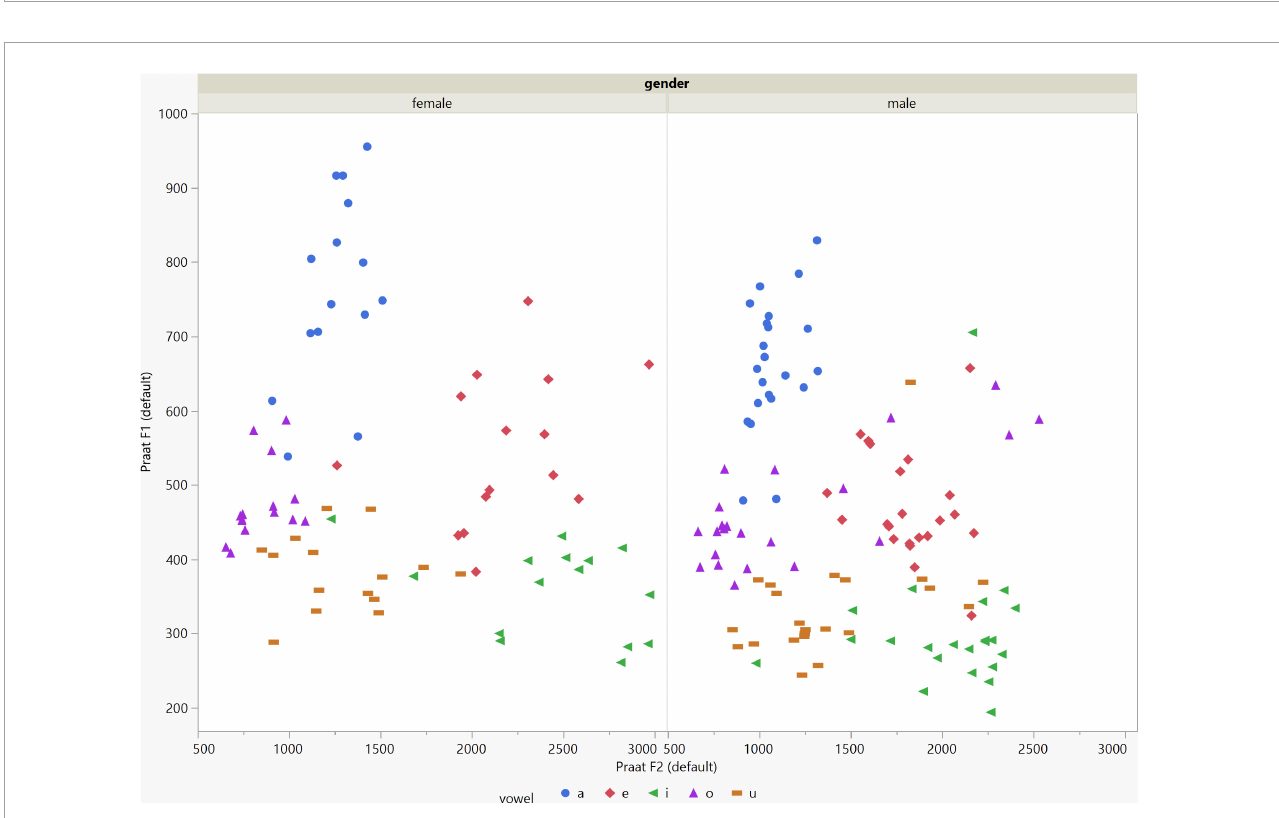
FIGURE3 Arrangement of the F1 and F2 data of the five vowels calculated using Praat with the default settings for both males and females.